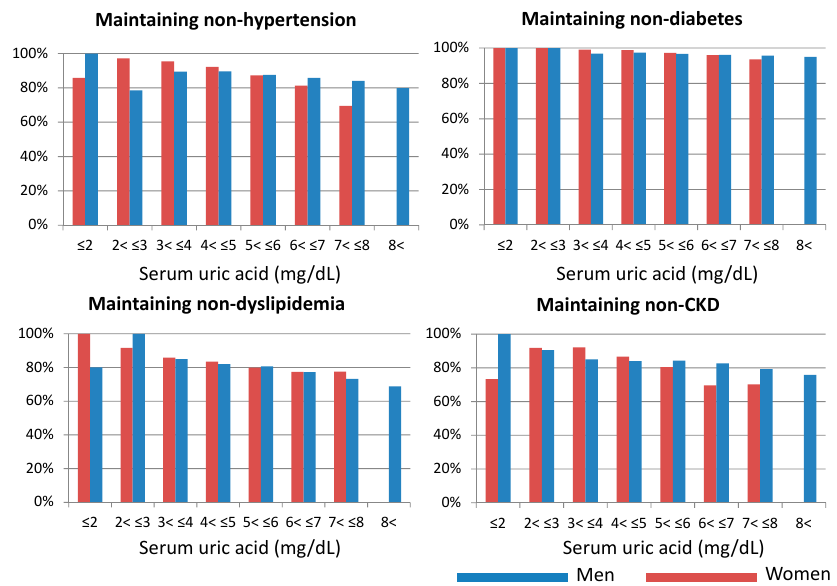
Figure 3. Maintaining rate of lacking hypertension, diabetes, dyslipidemia, and chronic kidney disease in each serum urate over five years. CKD, chronic kidney disease. Blue bars showed men and red bars showed women.